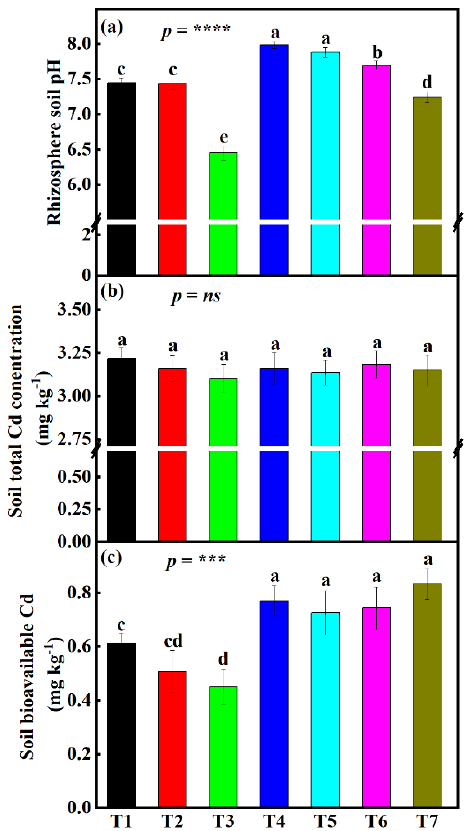
Figure 1. Influence of different fertilizer treatments on rhizosphere ( a ) rhizosphere soil pH, ( b ) soil total Cd concentrations, and ( c ) soil bioavailable Cd under small-scale plot experiment. Data (means ± SE, n = 5) followed by different subscripts denotes significant differences between treatments at p < 0.05 according to Tukey’s HSD. p -values of one-way ANOVA, are indicated: p < 0.001, ***; p < 0.0001, ****; ns , not significant. Treatments: sepiolite (Mg 4 Si 6 O 15 (OH) 2 •6(H 2 O)), 1.27 kg m − 2 (T1); sodium metasilicate (Na 2 SiO 3 ), 0.03 kg m − 2 (T2); humic acid, 0.07 kg m − 2 (T3); calcium magnesium phosphate fertilizer, 0.09 kg m − 2 (T4); ferrous sulfate (FeSO 4 ), 0.07 kg m − 2 + manganese sulfate (MgSO 4 ), 0.007 kg m − 2 (T5); 6) straw biochar, 0.75 kg m − 2 (T6); and the control treatment (no chemicals added) (T7). Table 3. The basic physicochemical properties of the soil before the addition of amendments. Chemical